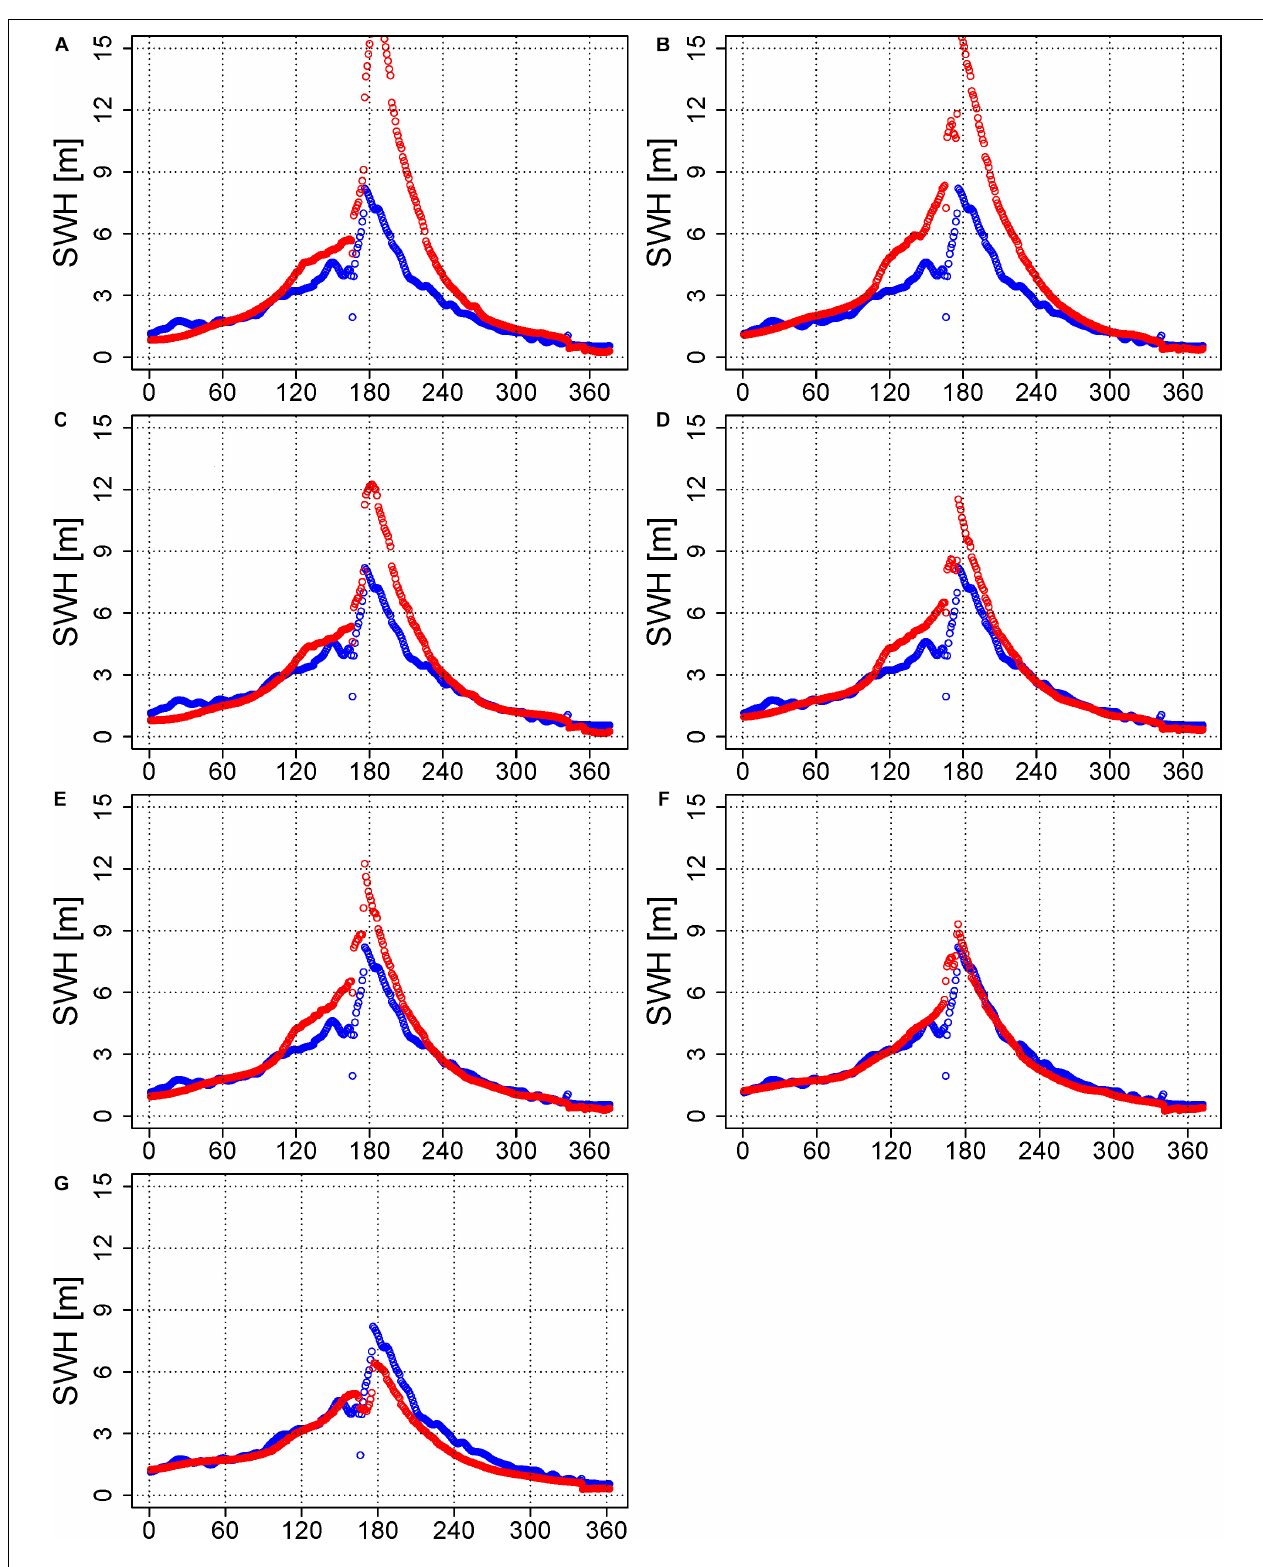
FIGURE 7 | Comparisons between the significant wave heights of the Sentinel-3B satellite data (blue points) and modeled data (red points) along the ascending satellite track (from southeast to northwest direction) in Figure 6 for (A) 1w_wind, (B) 1w_wind_SN, (C) 2w_new, (D) 2w_new_SN, (E) 2w_old_SN, (F) ECMWF, and (G)